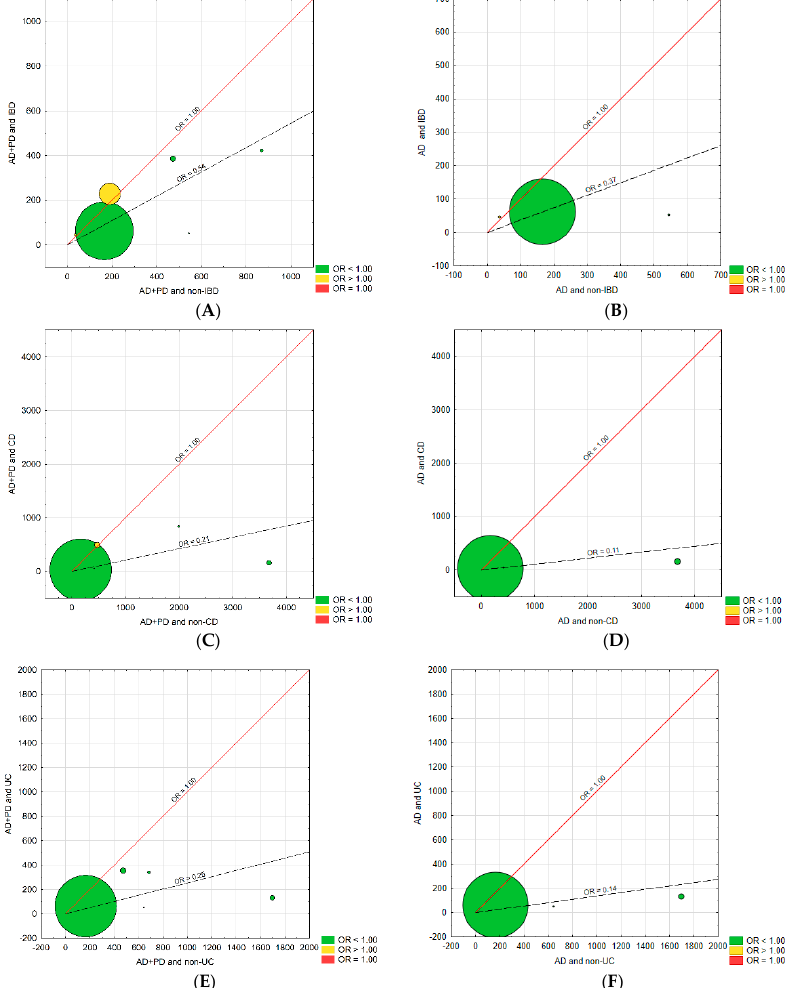
Figure 3. The L’Abbé chart—the relationship between the risk of neurodegenerative disease (AD + PD) in the group of patients with IBD and the control group ( A ); AD in the group of patients with IBD and the control group ( B ); neurodegenerative disease (AD + PD) in the group of patients with CD and the control group ( C ); AD in the group of patients with CD and the control group ( D ); neurodegenerative disease (AD + PD) in the group of patients with UC and the control group ( E ); AD in the group of patients with UC and the control group ( F ).